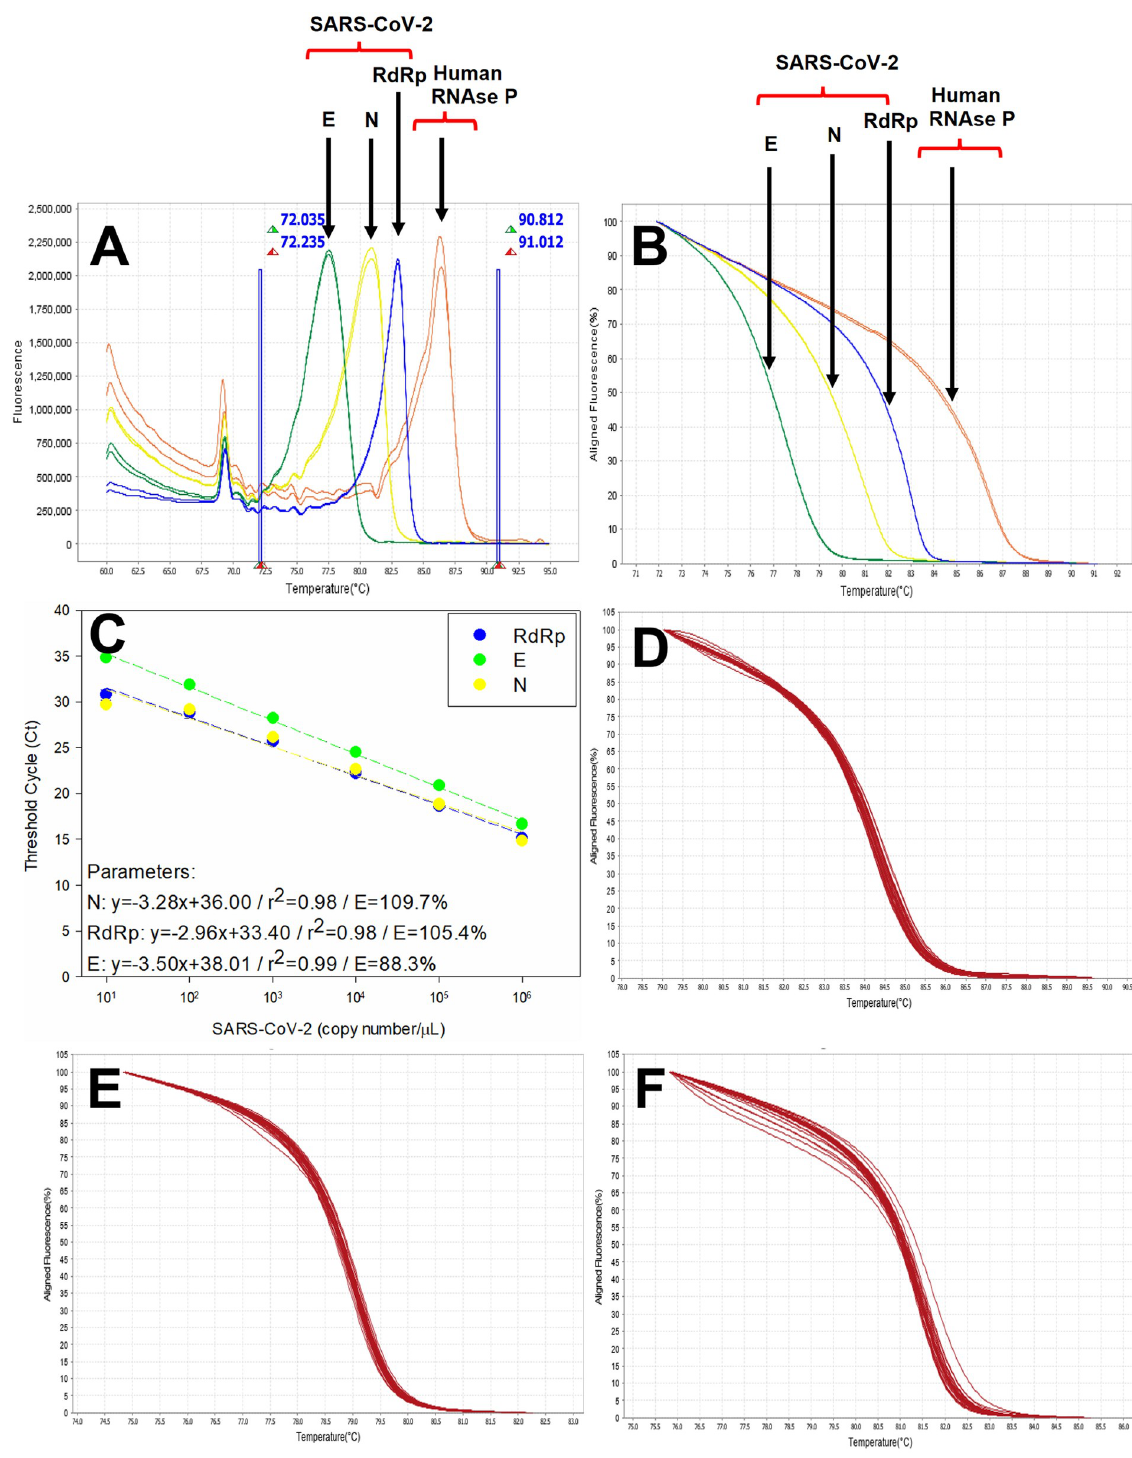
Fig 1. HRM-RTqPCR assays for SARS-CoV-2 E, N and RdRp targets. A . Derivative HRM curves for SARS-CoV-2 E (green), N (yellow) and RdRp (blue) and Human RNAse P (red) targets. The vertical blue lines divide the Pre-melt, Melt and Post-melt regions. B . Normalized HRM curves for SARS-CoV-2 E (green), N (yellow) and RdRp (blue) and Human RNAse P (red) targets. C . Dynamic extension (linearity) for the SARS-CoV-2 E (green), N (yellow) and RdRp (blue) gene target amplification. D . Normalized HRM curves for SARS-CoV-2 N region from COVID-19 clinical samples. E . Normalized HRM curves for SARS-CoV-2 RdRp region from COVID-19 clinical samples. F . Normalized HRM curves for SARS-CoV-2 E region from COVID-19 clinical samples.